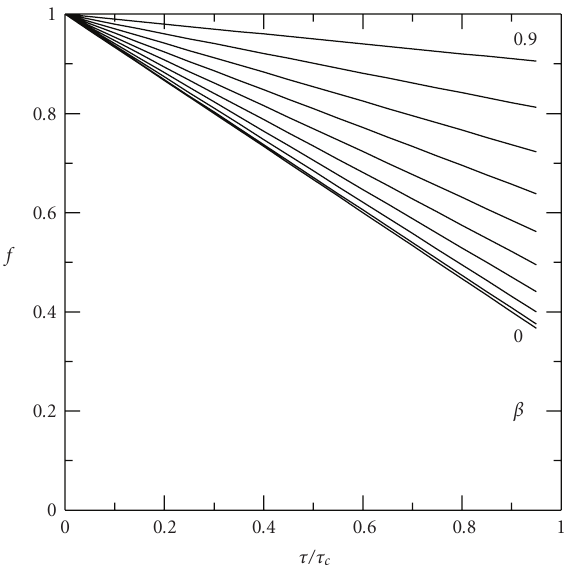
Figure 3: Eddington factor f appropriate for the LTE case as a function of the optical depth τ for the various values of the flow speed β . The values of β are from 0 to 0.9 in steps of 0.1 from bottom to